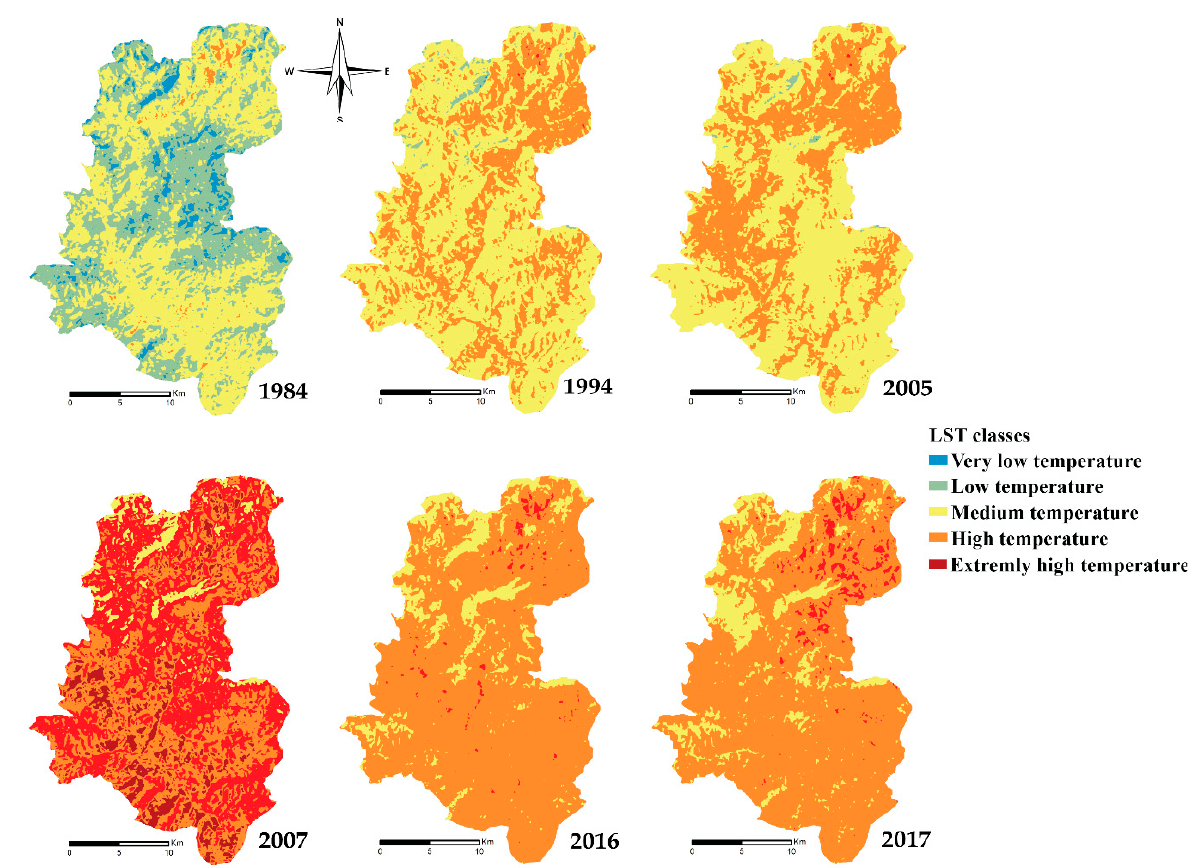
Figure 6. Monitoring of LST changes over the years from 1984–2017.